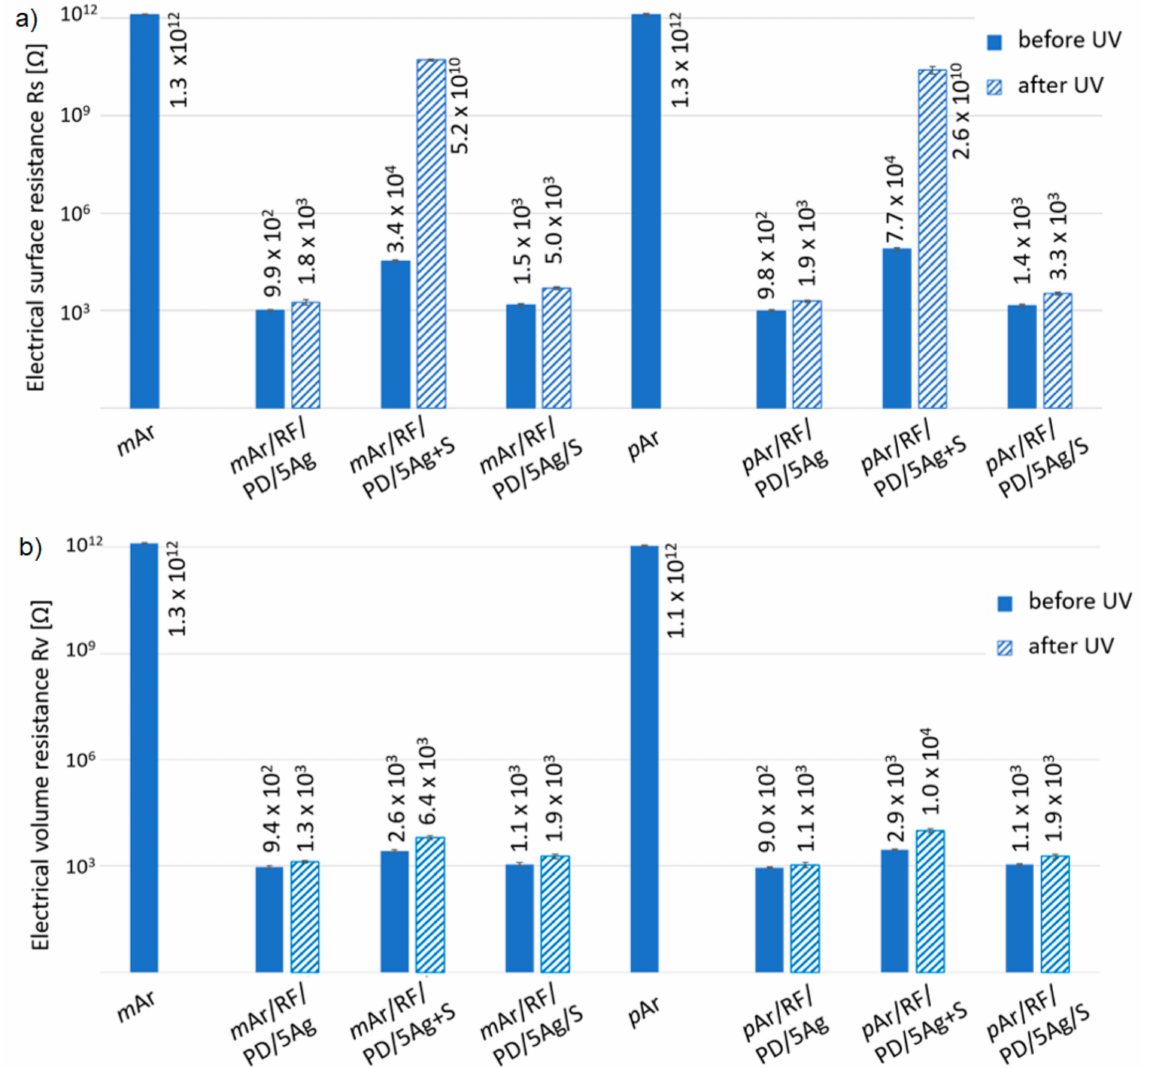
Figure 12. Electrical surface resistance (R s ) ( a ) and electrical volume resistance (R v ) ( b ) of unmodified and modified m Ar and p Ar fabrics before and after UV irradiation (365 nm, 96 h). The electrical volume resistance (R v ) value is 1.30 × 10 12 Ω and 1.06 × 10 12